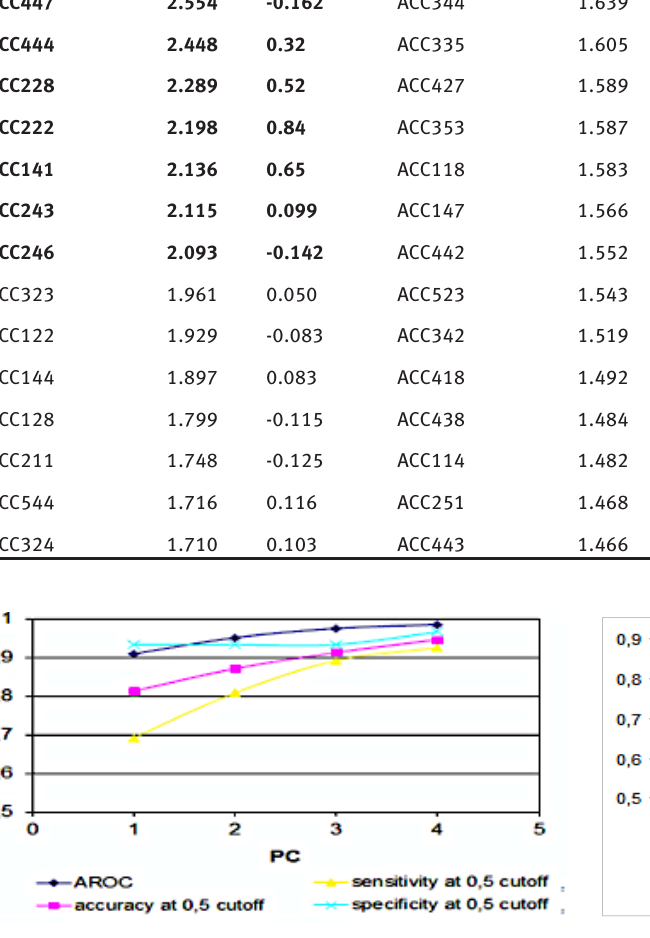
Figure 2: Sensitivity, specificity and accuracy at threshold 0.5, and AROC for the extended model for allergenicity prediction with different number of